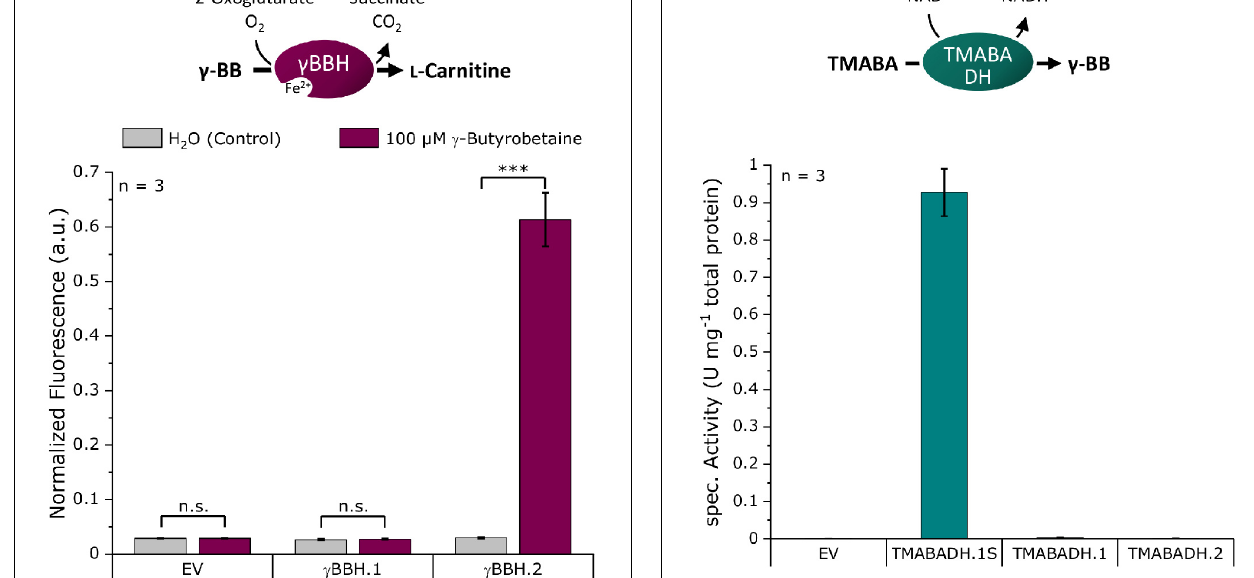
FIGURE 2 | Biosensor screening of potential γ -butyrobetaine hydroxylases from N. crassa . The artificial genes γ BBH.1 and γ BBH.2 derived from the ORFs NCU02196 and NCU12046, respectively, were cloned into pECXT99A and tested in the L -carnitine biosensor strain E. coli (cid:49) cai-fix (pGP2-Sensor1- caiCD ). The empty vector (EV) of pECXT99A was used as a control. The maximum normalized fluorescence signal observed during the cultivation process with 100 µ M γ -butyrobetaine or water as the control is shown. Error bars indicate the standard deviation of the mean of three replicates. Three asterisks ( ∗∗∗ ) indicate a p -value ≤ 0.001 in a student’s t -test; n.s., not significant.